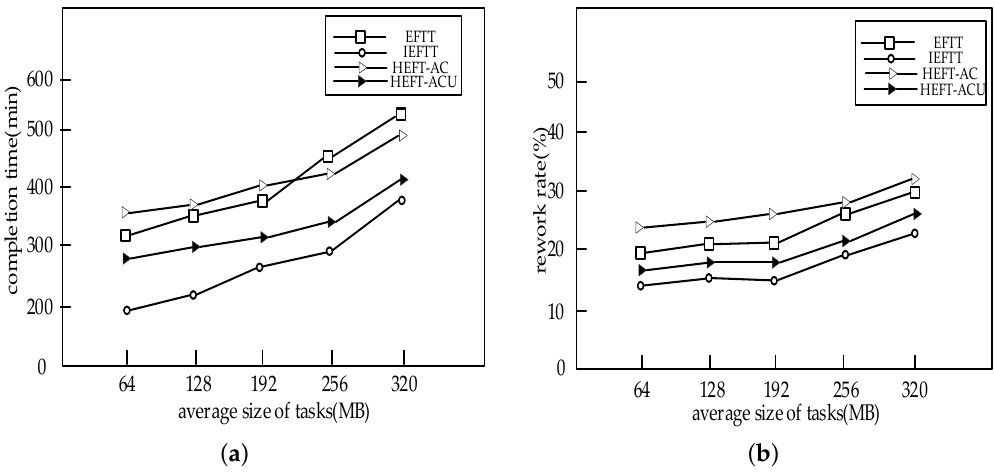
Figure 10. The impact of average size of tasks on the performance of the algorithms: ( a ) The impact of average size of tasks on task completion time; ( b ) The impact of average size of tasks on rework